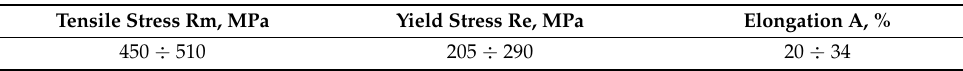
Table 2. Mechanical properties of AMS 5504 steel [29].